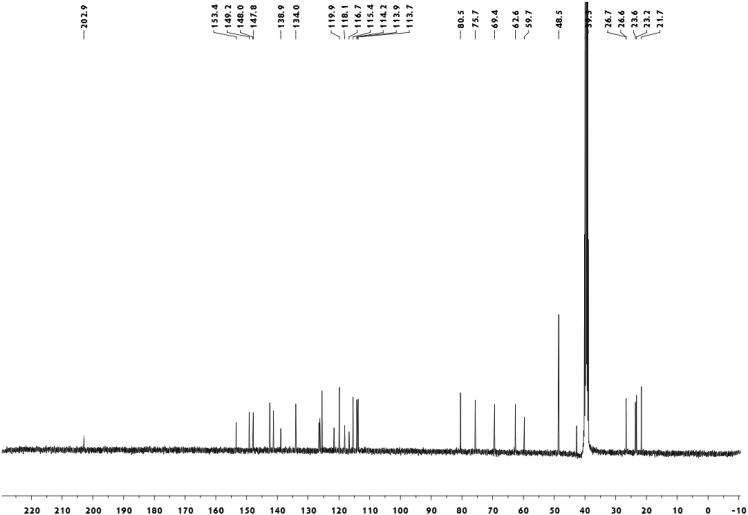
13C-NMR spectrum of meroterpenoid 8.